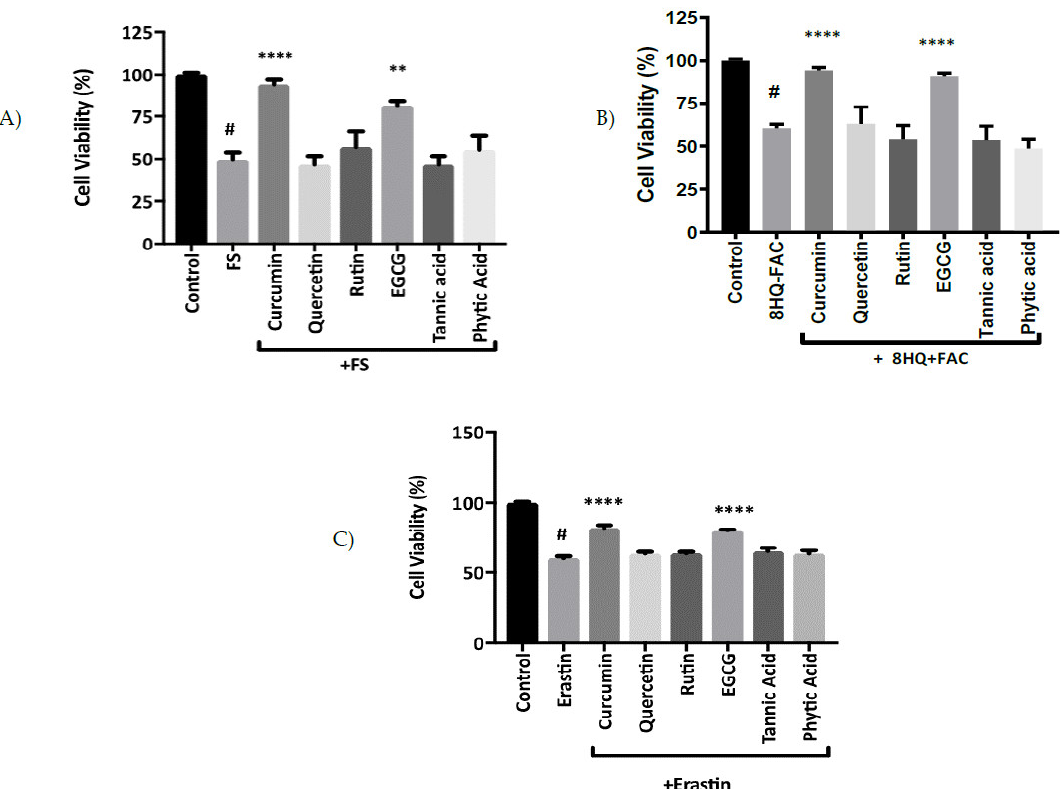
Figure 1. Protective effects of different polyphenols against iron-mediated toxicity and ferroptosis. MIN6 cells were treated with 20 µ M curcumin, quercetin, rutin, EGCG, tannic acid or phytic acid for 24 h and supplemented with ( A ) Fenton Substrates (FS), ( B ) 8HQ+FAC for 2 h and ( C ) MIN6 cells were treated overnight with 20 µ M erastin, in the absence or presence of quercetin, rutin, curcumin, tannic acid, phytic acid and EGCG. The percentage of cell viability is relative to control cell samples. Curcumin and EGCG inhibited erastin-induced cell death in a dose-dependent manner. Curcumin and EGCG had a protective effect against ferroptosis at 20 µ M in MIN6 for 24 h, with a valuable statistical difference between erastin and cell treated with erastin + 20 µ M curcumin or EGCG. All the values are expressed with the mean ± SEM, n = 8. # p < 0.05 control vs. treatment groups, **p < 0.01 and ****p < 0.0001 compared with FS and 8HQ+FAC group only. ( C ) # p < 0.05 control vs. treatment groups, ****p < 0.0001 vs. erastin only. One-way ANOVA, Tukey post-hoc test.